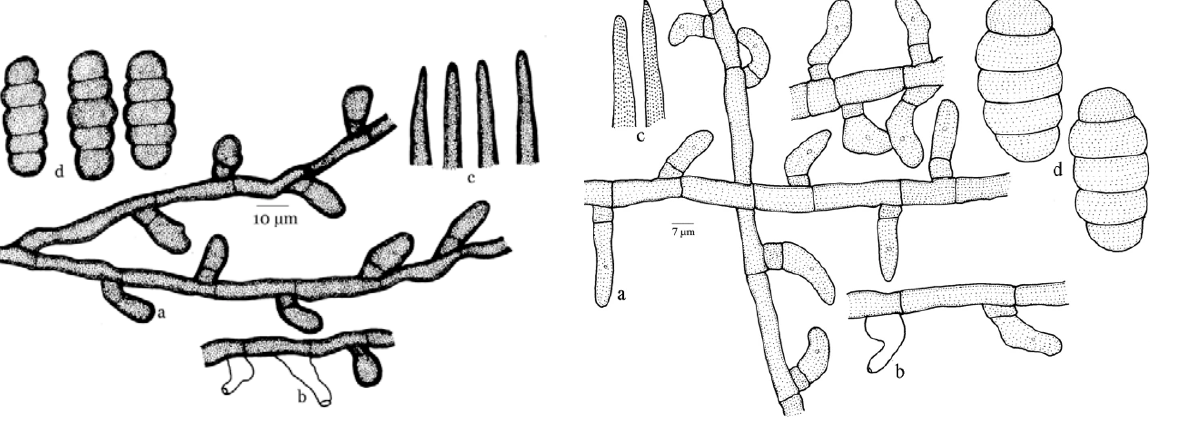
Figure 118. Meliola symplocicola a - Appressorium; b - Phialide; c - Apical portion of mycelial setae; d - Ascospores